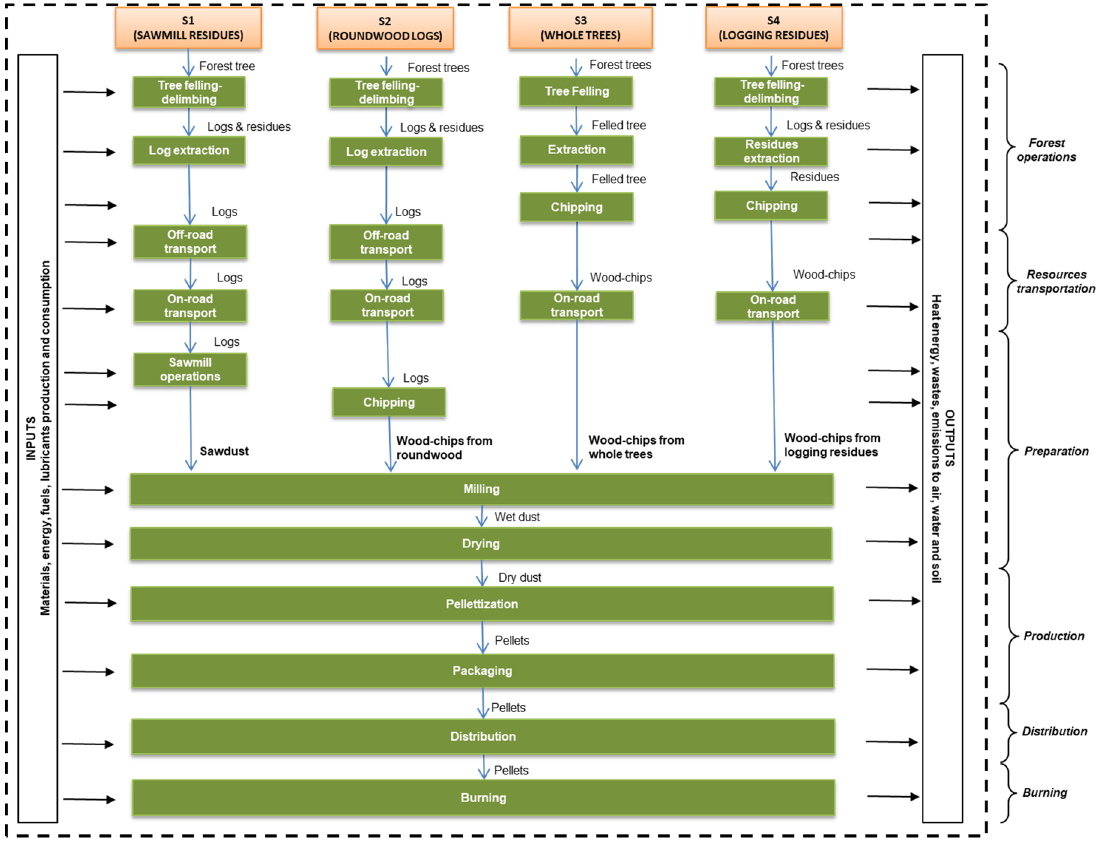
Figure 1. Process flow diagram of the investigated wood pellet supply chains. The dotted line shows the system boundary. Macro-phases are listed on the right of the figure.